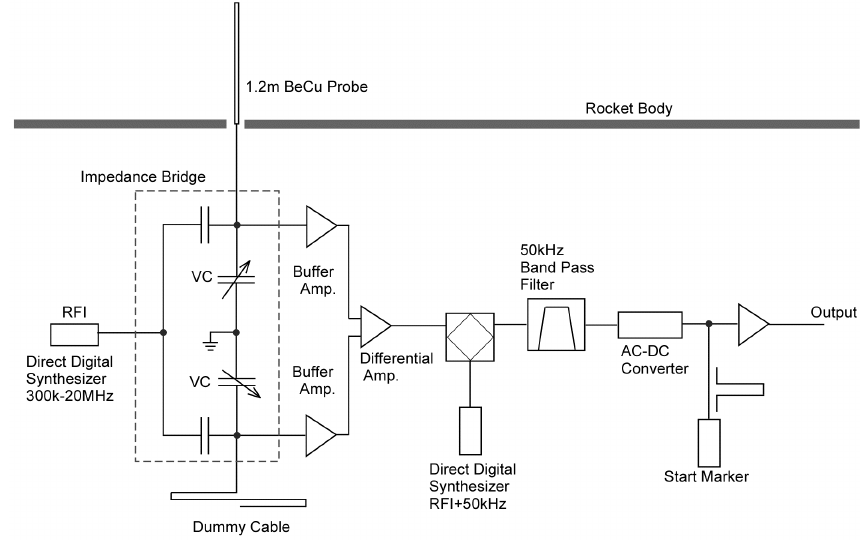
Fig. 1. The block diagram of NEI on board the S310-31 and S310-32 rockets. The bridge circuit is enclosed with a dashed line. Figure 1. The block diagram of NEI on-board S310-31 and -32 rockets. The when the RF frequency coincides with the UHR bridge circuit is enclosed with dashed line.